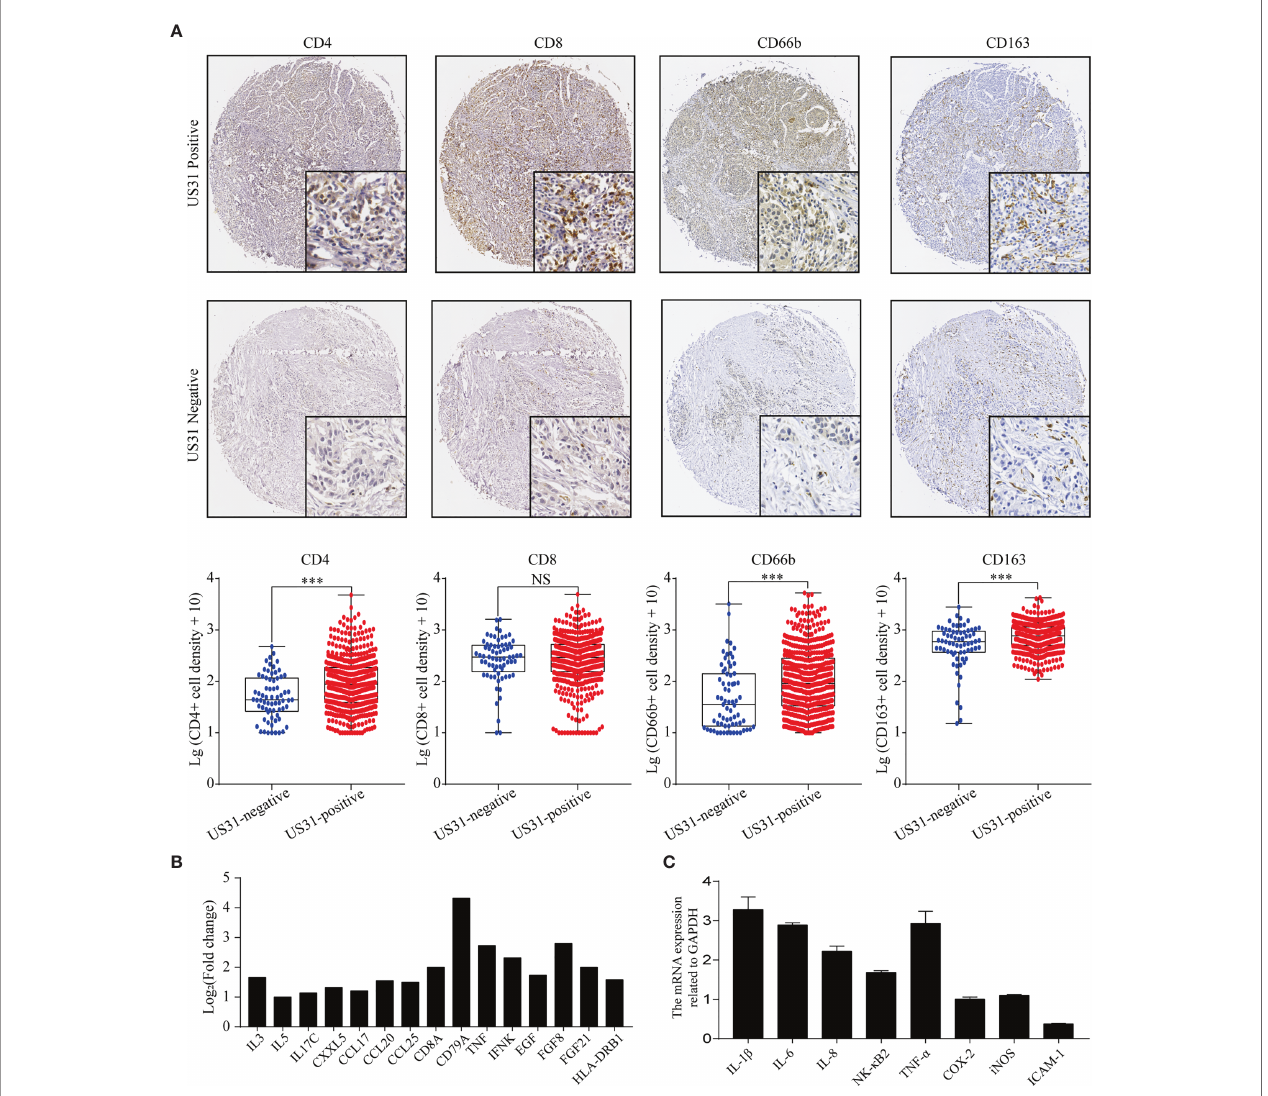
FIGURE 3 | Association between US31 expression and various tumor-in fi ltrating immune cells and the immune response regulated by US31 expression of gastric cancer (GC) cells. (A) Representative immunohistochemical staining of tumor-in fi ltrating immune cells (CD4+, CD8+, CD66b and CD163 cells) in US31 positive and negative tissues. Overview picture is 100×; detailed picture is 400×. And the association between US31 expression and those tumor-in fi ltrating immune cells. (B) mRNA levels of representative immune-related genes measured by RNA-seq. (C) mRNA levels of representative immune-related genes in GC cells with US31 overexpression detected by real-time quantitative polymerase chain reaction. ***P < 0.001. ns, no signi fi